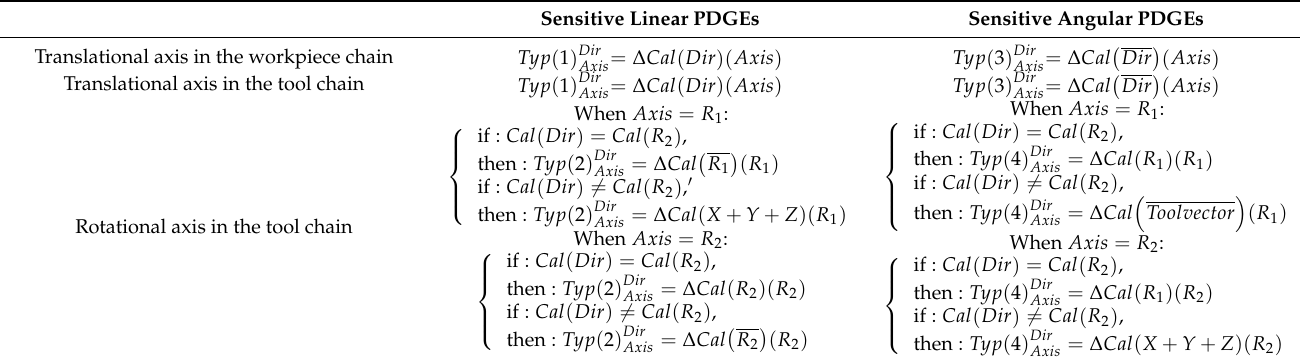
Table 4. Mapping expressions of TTTRR-type five-axis machine